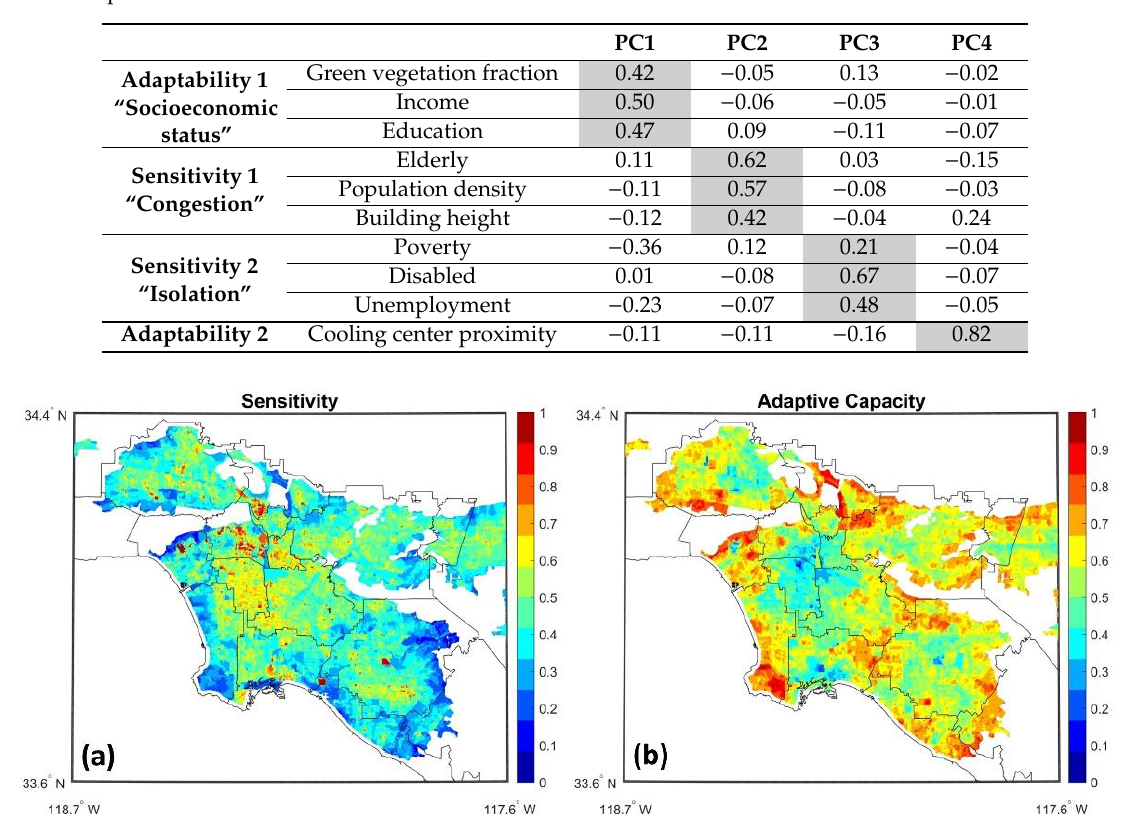
Figure 3. ( a ) Sensitivity and ( b ) adaptive capacity images derived from socio-demographic and environmental variables and their principal component coefficients from Table 2.